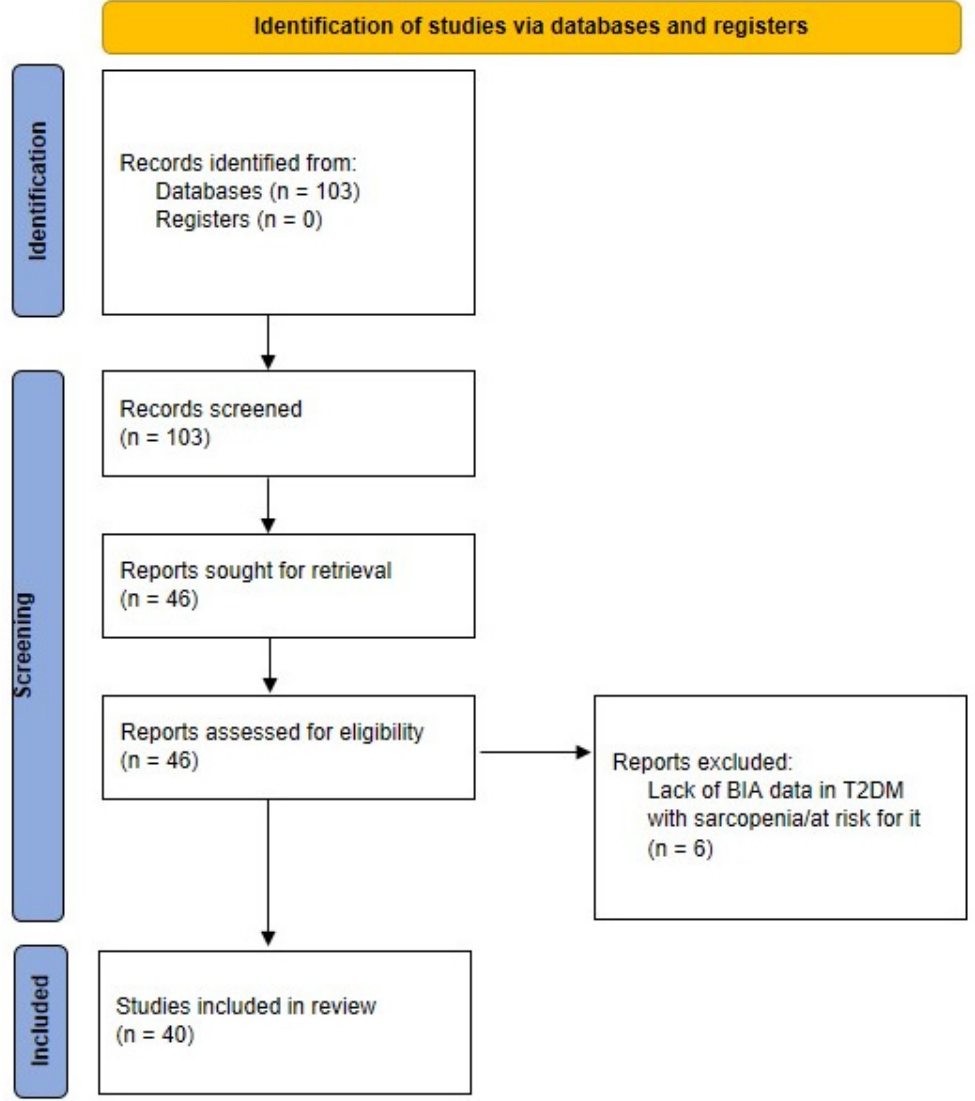
Figure 1. PRISMA flow diagram of the scientific literature search strategy.